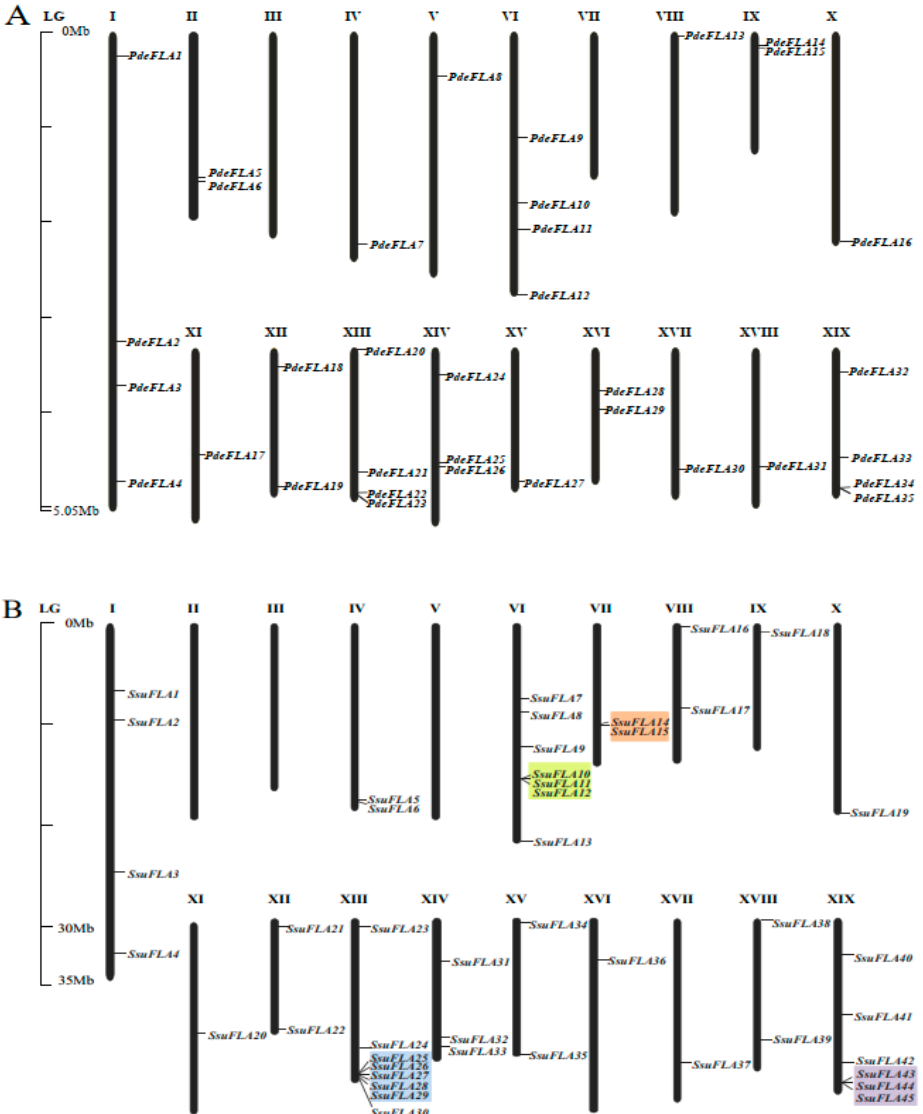
Figure 1. Location of FLA genes on chromosomes. Distribution of FLA gene family members on chromosomes in P. deltoides ( A ) and S. suchowensis ( B ). Genes are named according to their order on the chromosomes. Identified tandem repeat genes are highlighted using a colored background.